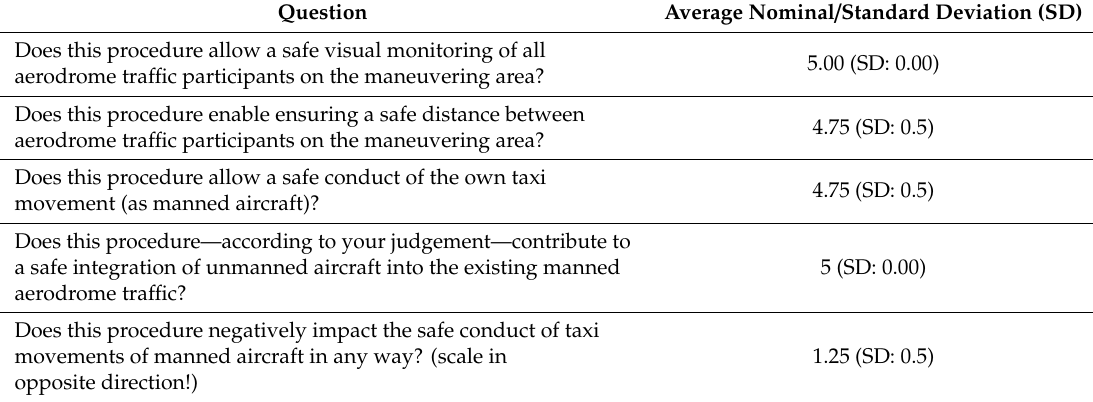
Table 3. Results of tailor-made questionnaires related to safety in nominal situations, answered by conventional